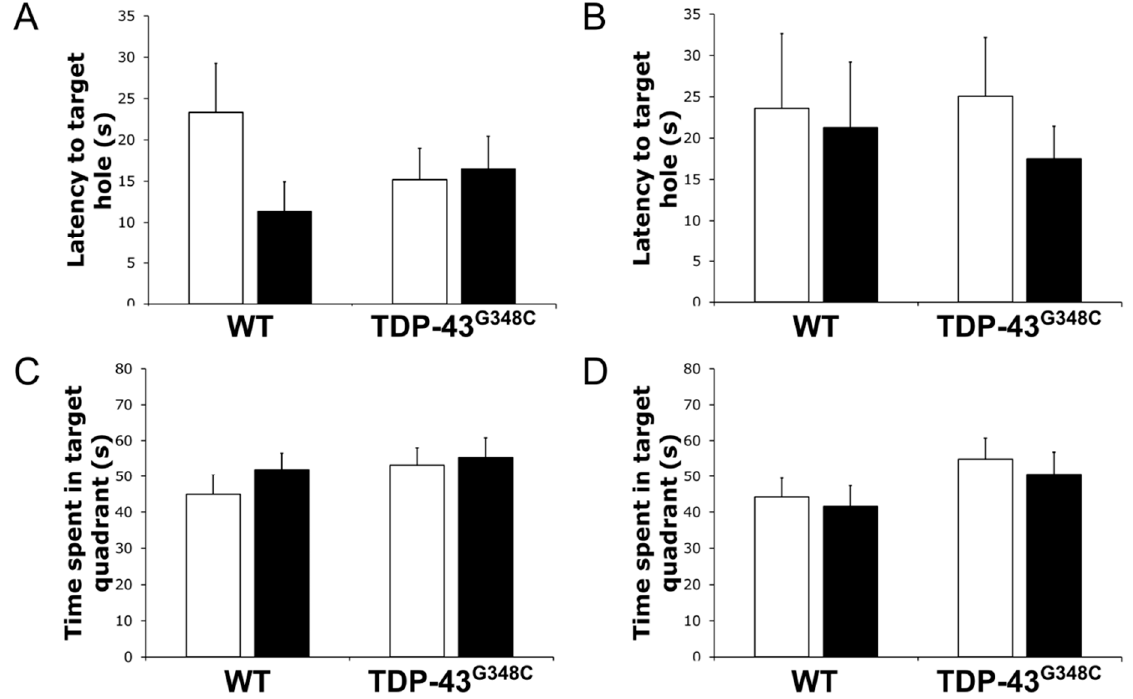
Figure 6. Barnes maze task performance in wild-type (WT) and TDP-43 G348C mice at 6 months after repetitive mild traumatic brain injury (rmTBI). The histogram shows the latency time (s) to reach the target hole during ( A ) the tests and ( B ) the retests or the time (s) spent in the target quadrant during ( C ) the tests and ( D ) the retests for mice with rmTBI ( (cid:4) ) and related control groups ( (cid:3) ). Results are expressed as means ± SEM ( N =